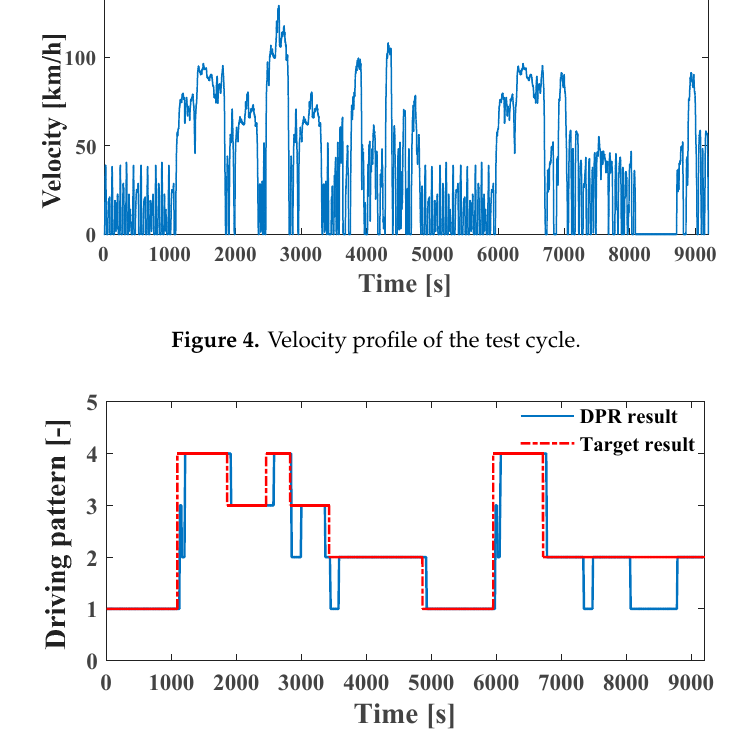
Figure 5. Real-time driving pattern recognition (DPR) verification.